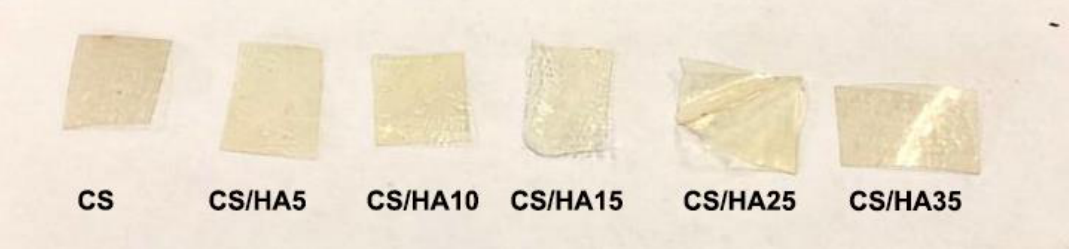
Figure 4. Photos of CS and CS/HA 2D-matrices.